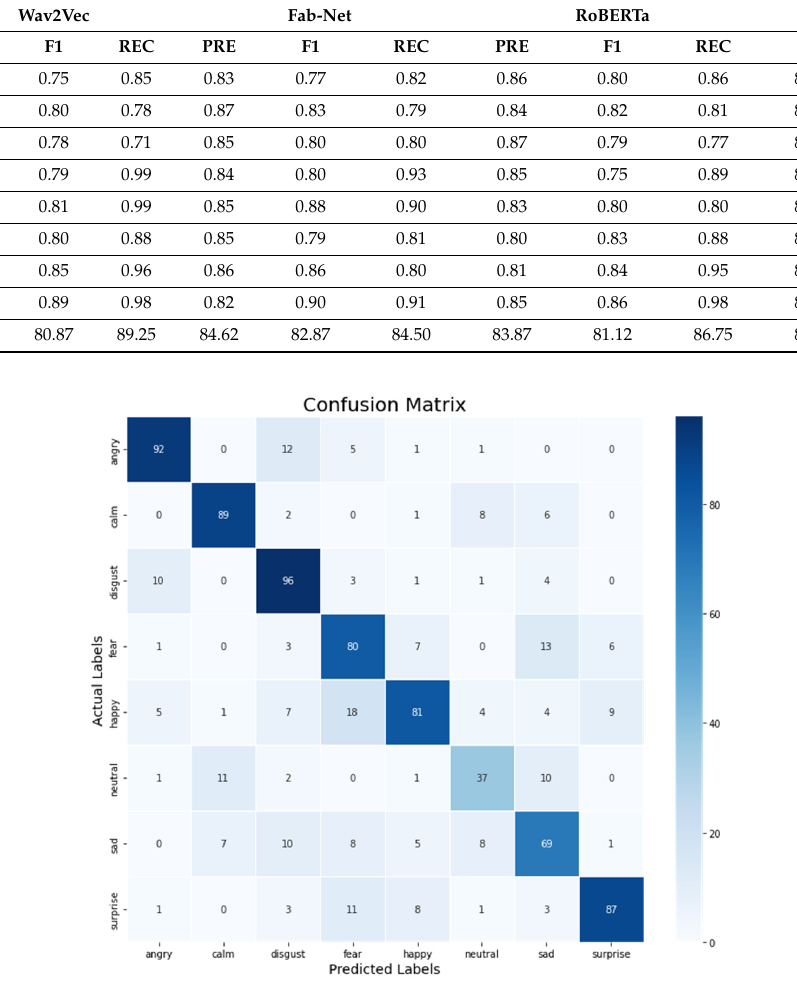
Figure 6 . Confusion matrix for all emotion categories. Figures 7 and 8 represent the plotting of training and testing accuracy and loss with regard to every epoch. This graph also showcases that there were no over-fitting or unbe- fitting in our training method.